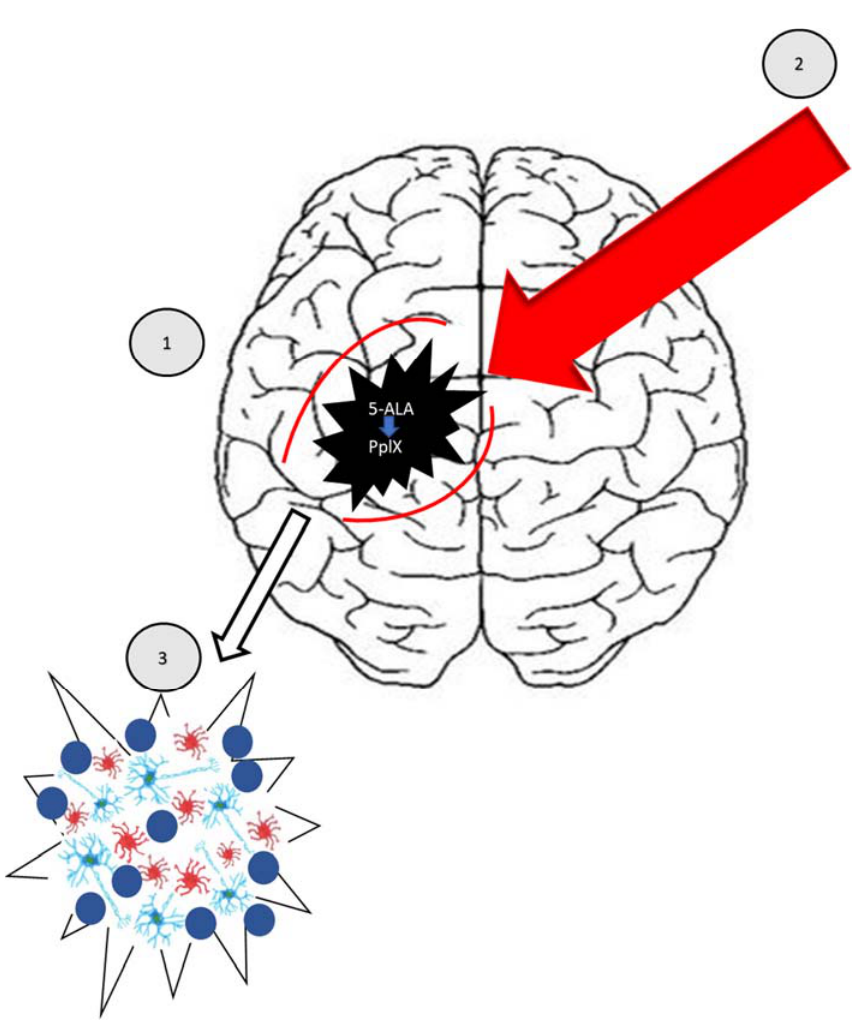
Figure 5. PDT in brain tumor degradation (source: own elaboration).